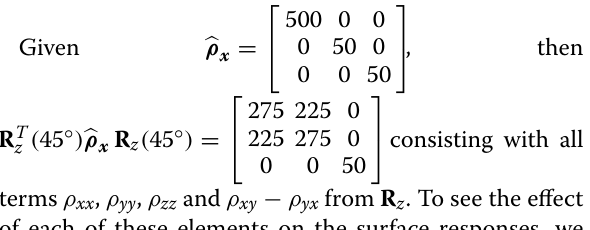
Fig. 10 a The surface logarithmic plot of Z inf xy ( s ) , Z inf yx ( s ) , Z inf xx ( s ) , and Z inf yy ( s ) , and T edge x ( s ) , and T edge y ( s ) at all 484 stations from top to bottom rows, respectively, obtained when the 3‑D anisotropic body in Fig. 1 (shown as a dashed line) is assigned with R T z ( 45 ◦ ) surface (0 km), and at a depth of 5 km, given R T ◦ ) ρ x R z ( 45 ◦ ) , z ( 45 (cid:31)